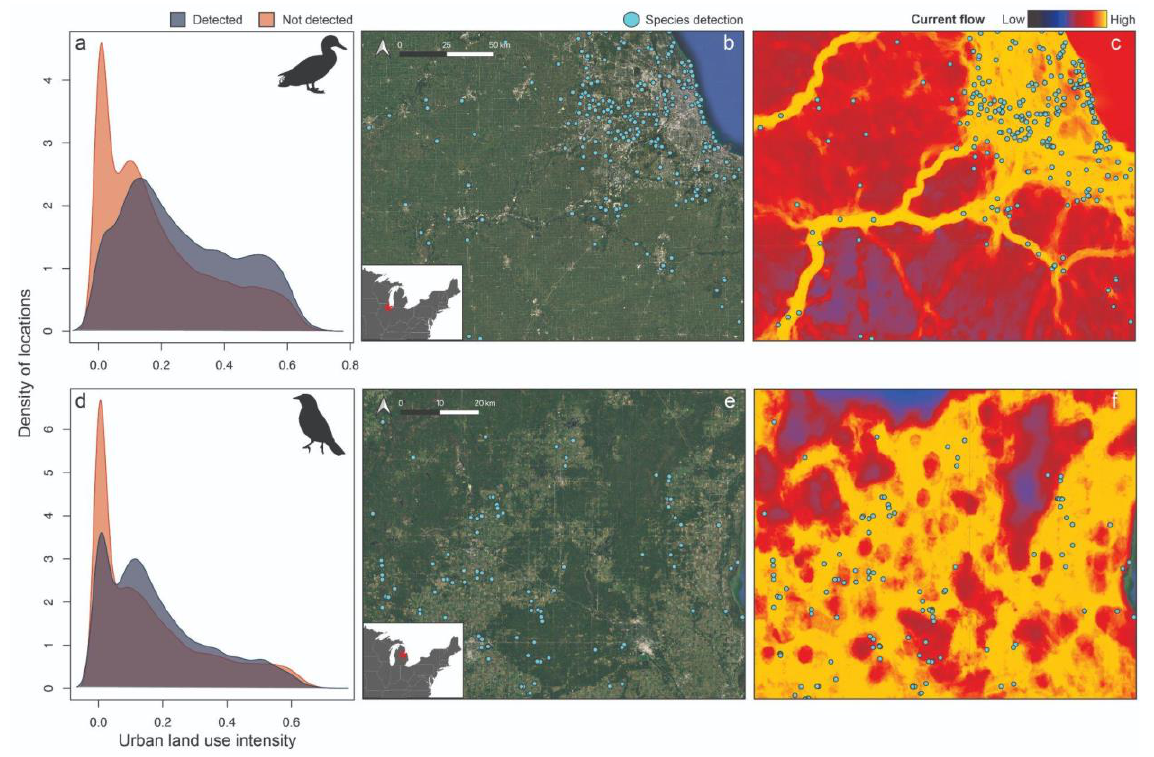
Figure 5. Use of developed habitats by American Black Duck (black duck; top row) and Bobolink (bottom row). Kernel density plots ( a , d ) show the distribution of urban land use intensity values at locations where each species was detected (blue) and not detected (orange). Satellite imagery ( b , e ) and corresponding connectivity surfaces ( c , f ) show species’ locations and predicted movement potential (current flow) across development gradients in two example landscapes.